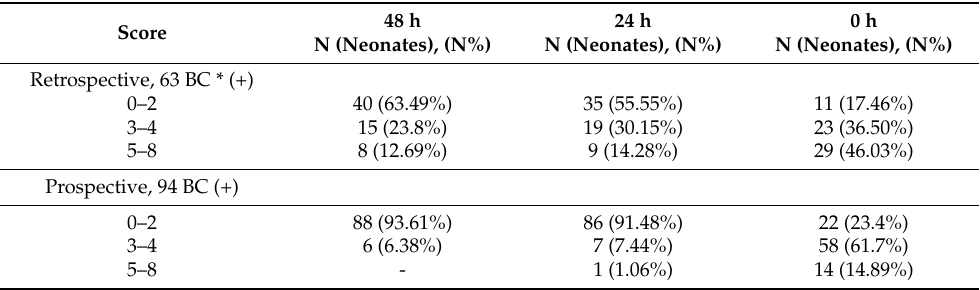
Table 6. Number of septic neonates according to the value of the Sepsis Prediction